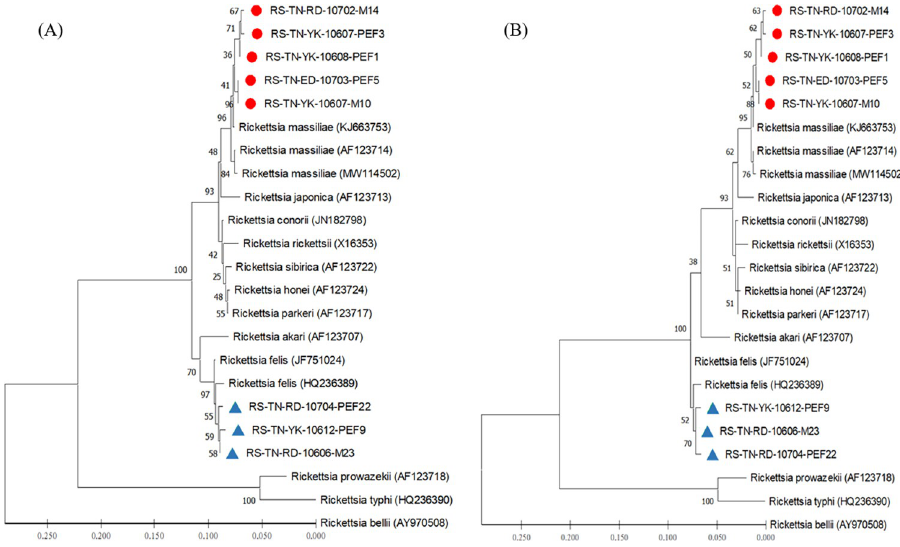
Fig 4. Phylogenetic relationships based on the outer membrane protein B ( ompB ) gene. Sequences of Rickettsia between 8 specimens (indicated as ● & ▲) detected in Rhipicephalus sanguineus ticks from Tainan City of Taiwan and 15 other Rickettsia specimens identified from various biological and geographical origins. The Tainan strains were genetically affiliated with the R . massiliae (indicated as ●) and R . felis (indicated as ▲), respectively. The trees were constructed and analyzed by (A) neighbour-joining and (B) maximum likelihood methods using 1000 bootstraps replicates. Numbers at the nodes indicate the percentages of reliability of each branch of the tree. Branch length is drawn proportional to the estimated sequence